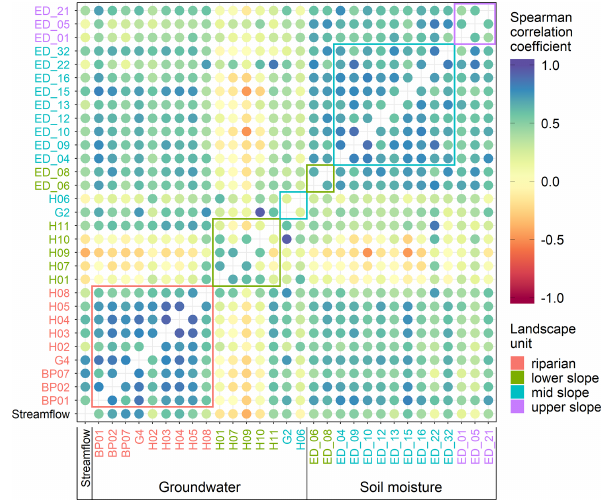
Figure 6. Median Spearman correlation coefficient between stream- flow at catchment outlet (streamflow), groundwater stations (BP ∗ , H ∗∗ , G ∗ ) and soil moisture stations (ED_ ∗∗ ) for all events. The cir- cles’ colour corresponds to the Spearman correlation coefficient. The station names’ colour corresponds to their landscape unit. Coloured rectangles enclose correlations of stations in the same landscape